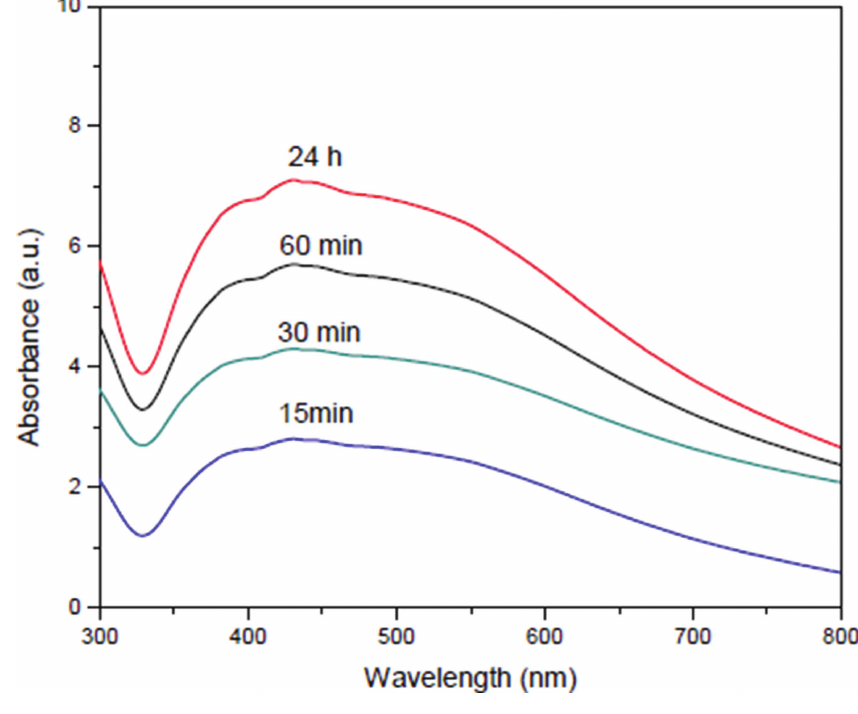
Figure 3: UV-Vis spectra of reacting medium at specific intervals.